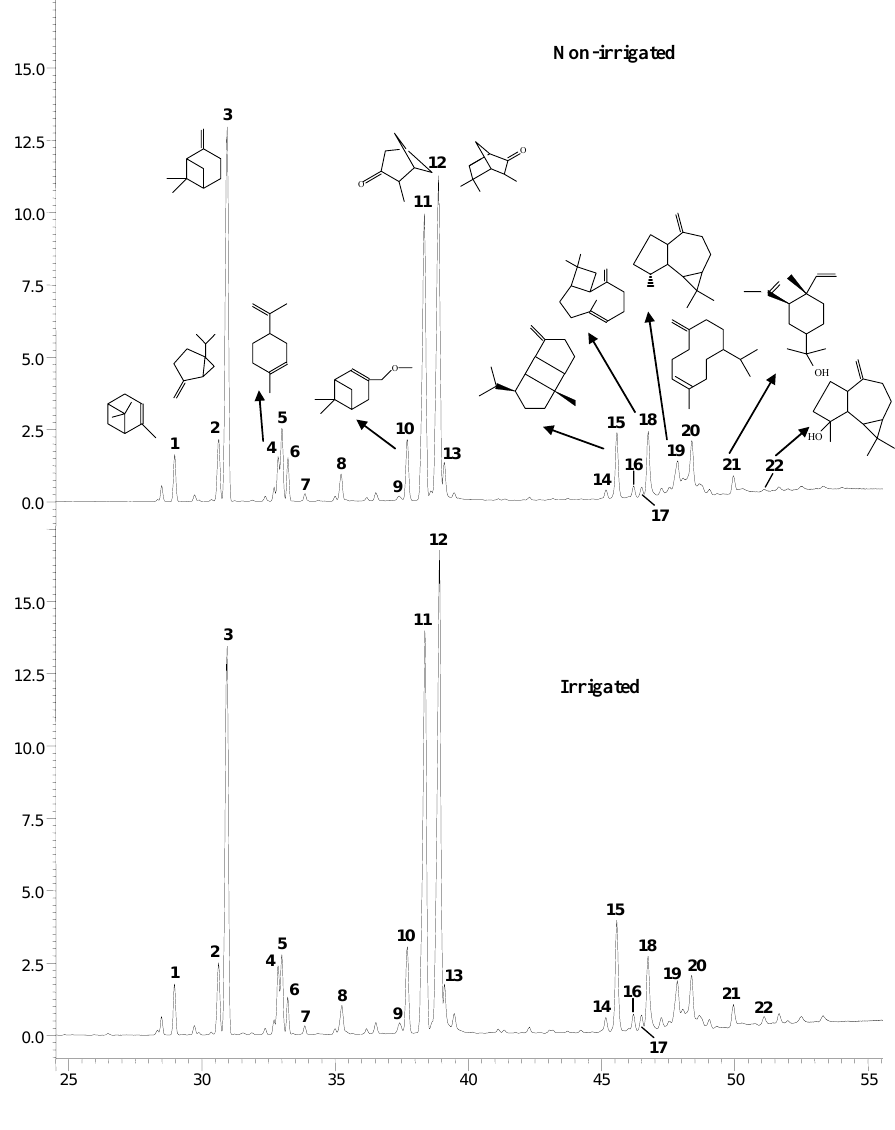
Figure 1. Representative GC profiles of Hyssopus officinalis L. from irrigated and non-irrigated crop. Chemical structures for ISO 9841 compounds are